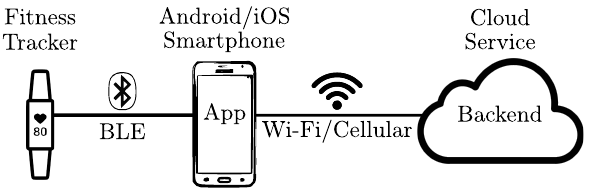
Figure 1: Xiaomi fitness tracking system architecture. The tracker is a battery-powered embedded device supporting BLE. The smartphone runs a fitness tracking application and is capable of communicating with the tracker via BLE and with a backend server via the